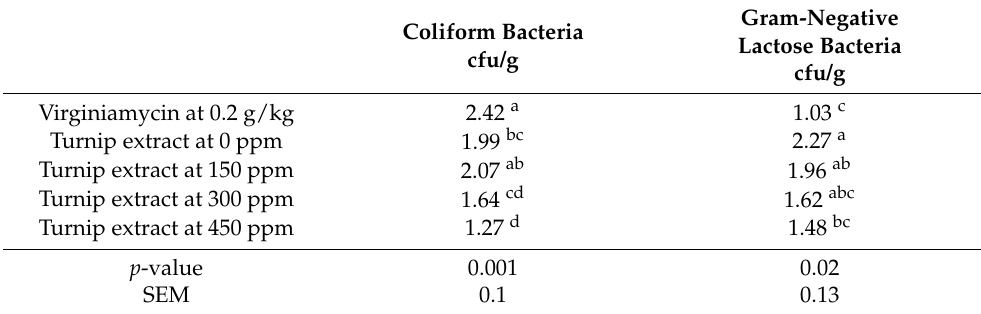
Table 7. Means ± SEM of cecum microbiota parameters at day 42, for Ross 308 broilers supplemented with different levels of Brassica rapa extract at 0–450 ppm or Virginiamycin from weeks 1–6